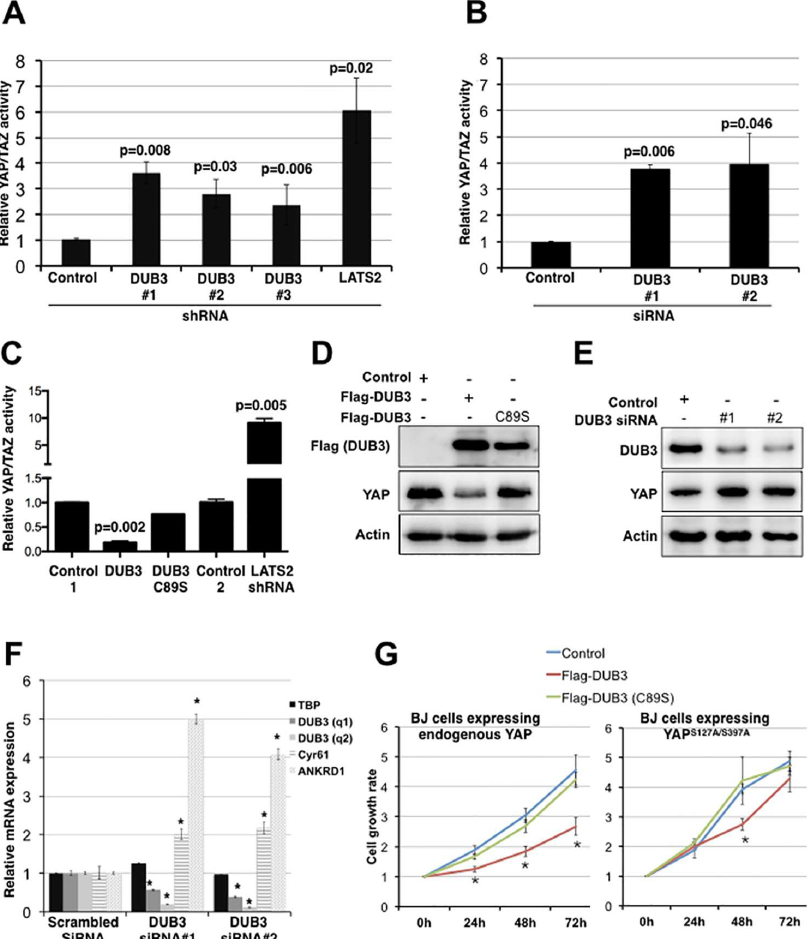
Fig 1. DUB3 regulates Hippo activity by mediating YAP turnover. (A) Luciferasereporter assays showing the effects of DUB3 shRNAson YAP/TAZ activity. HEK293T cells weretransfectedto express the 8XGTIIC_luc YAP/TAZ reporter, which contains 8 TEAD bindingsites to control the expressionof firefly luciferaseand a vector expressingCMV-Renilla luciferase to normalizefor transfection efficiency, together with independent shRNA vectors to deplete DUB3 or with a control shRNA. shRNA to deplete LATS2 was used as a positive control. Data represent the averageof three independent transfection experiments ± SD. P values were determined using Student’s T-test (2-tailed, unequalvariance). (B) Luciferase reporter assays showingthe effects of DUB3 siRNAs on YAP/TAZ activity. HEK293Tcells weretransfected to expressthe luciferasere- porters together with independentsiRNAs to depleteDUB3 or with a control scrambled siRNA. Data represent the averageof three independent transfection experiments ± SD. P valuesweredetermined usingStudent’s T-test (2-tailed,unequalvariance). (C) Luciferasereporter assays showingthe effect of DUB3 on YAP/TAZ activity. HEK293Tcells were transfected to expressthe luciferasereporters together with a vector expressing Flag-DUB3, the C89S mutant form of DUB3 or relevant controls vectors. shRNA to depleteLATS2 was used as a positive control. Data representthe averageof three independent replicates ± SD. P valueswere deter- minedusingStudent’s T-test (2-tailed,unequalvariance). (D) Immunoblots showingthe effect of DUB3 expression on YAP protein. HEK293T cells weretransfectedwith a vector expressingFlag-DUB3, the C89S mutant form of DUB3 or a control vector. Blots were probedwith anti-YAP antibody and anti-Flag. Anti-Actin was usedto control for loading.(E) Immunoblots showingthe effect of DUB3 depletion on the YAP expression level. HEK293Tcells were transfected with independent DUB3 siRNAs or a scrambledsiRNA control. Blots wereprobedwith anti-YAPantibodyand anti-Flag. Anti-Actin was used to control for loading.(F) Effect of DUB3 siRNAs on the expression of YAP transcriptionaltargets. HEK293Tcells were transfected with DUB3 or controlsiRNAs. mRNA expression of DUB3, Cyr61, ANKRD1was measuredby RT-PCR. GAPDH mRNA was usedfor normalization and TBP was used as an additionalcontrol gene. Data representthe averageof 3 independent experiments ± SD. * indicatesp < 0.01,comparedto the relevantcontrols (Student’s T-test; 2-tailed,unequalvariance).(G) Effect of DUB3 on cell growth. Human primaryfibroblastBJ cells were engineered to expresshTert, H-Ras G12V and to depletep53 andp16, or with the additionor YAP S127A/S397A